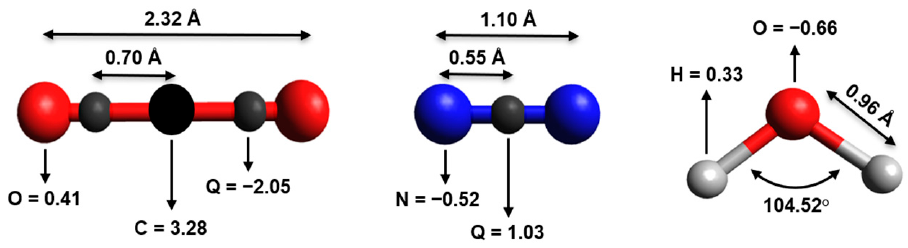
Figure 1. A schematic view of carbon dioxide, nitrogen, and water molecules, with the atomic charges (a.u.), angles, and bond lengths adopted. Charge-sites (Q) are represented by the smaller gray spheres. The second (non-electrostatic) component of the intermolecular potential, acting be- tween pairs of gas molecules and between the gas molecules and the membranes, is deter- mined by the balance of size repulsion with dispersion and induction attraction. As previ- ously, it has been described by pair-wise additive contributions, arising from the different interaction centers distributed again on each molecular frame, and formulated using the improved Lennard-Jones (ILJ) potential function [55]. The ILJ expression, adopted in place of the much simpler Lennard-Jones function (usual in generic force fields) describes non- electrostatic intermolecular interactions in a far more accurate way [56–58]. All the ILJ parameters used in this work, predicted from the polarizability component assigned at each interaction center, were tested and fine-tuned using the available experimental findings, exploiting the comparison of interaction energies with the results of high-level ab initio calculations [49,50]. A cut-off distance for the ILJ and electrostatic interactions was set to be equal to 15 Å. Given the periodic boundary conditions, the smoothed particle mesh Ewald method, as implemented in the DL_POLY software (see below), was applied to accurately account for long-range electrostatic interactions